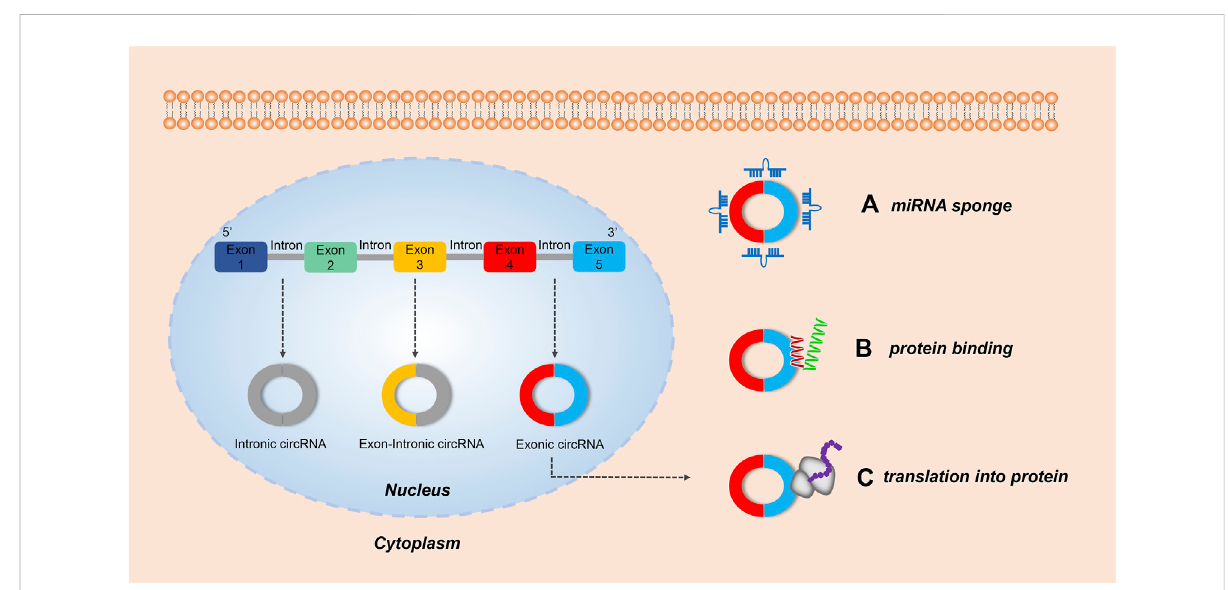
ThebiologicalfunctionsofcircRNAs.BothintroniccircRNAsandexon-circRNAsplayaroleinthenucleus,whileexoniccircRNAsexhibitseveral roles in the cytoplasm. (A) Acting as a miRNA sponge: by adsorbing miRNA, some exonic circRNAs can regulate the function of miRNA-target mRNAs. (B) Serving as a protein sponge: several exonic circRNAs can interact with RNA-binding proteins (RBP) and mediate their action.